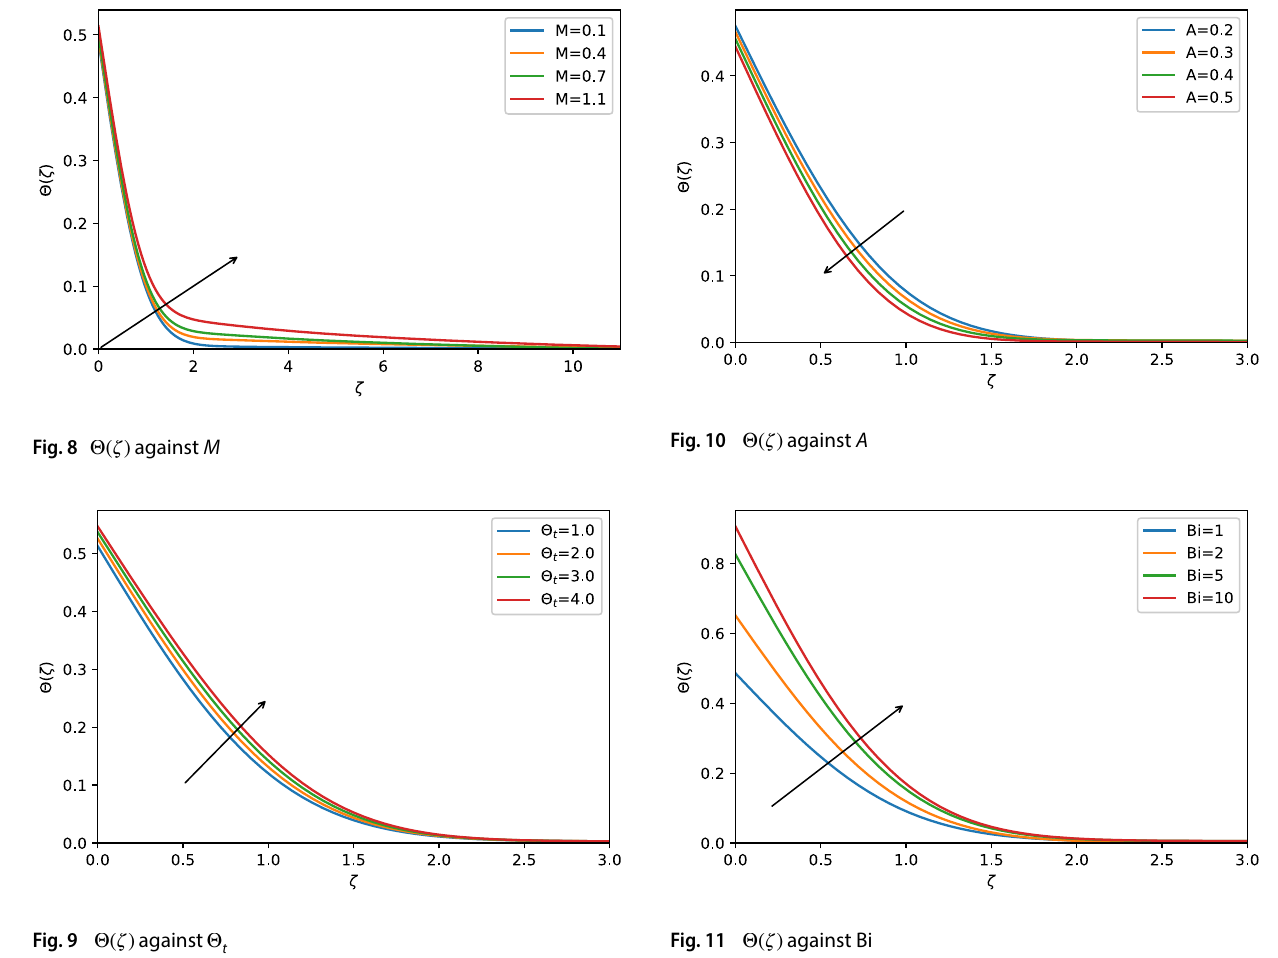
Fig. 9 Θ( 𝜁 ) against Θ t